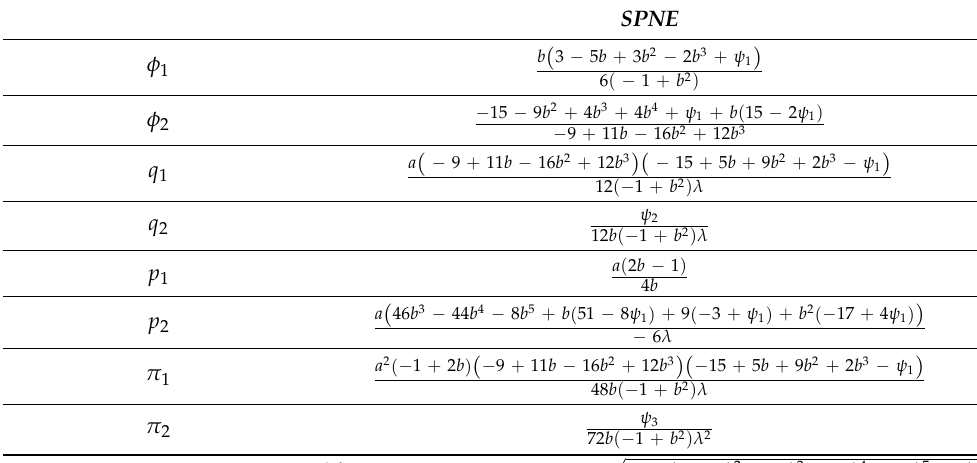
Table 4. Equilibrium values in the Cournot–Bertrand (C–B) model: SPNE-B .